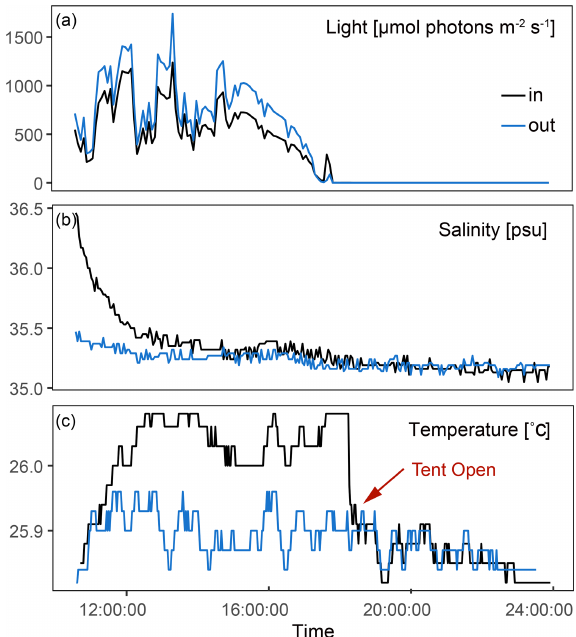
Figure 3. Exterior and interior measurements for three representa- tive incubations performed throughout this study. (a) Difference in light between the inside of the tent and the ambient environment during an incubation. (b) Injection of salt within the tent at the start of the incubation and its gradual return to ambient salinity. (c) Tem- perature within the tent compared to exterior conditions; when the tent is opened at the end of the incubation, temperature immediately returns to ambient